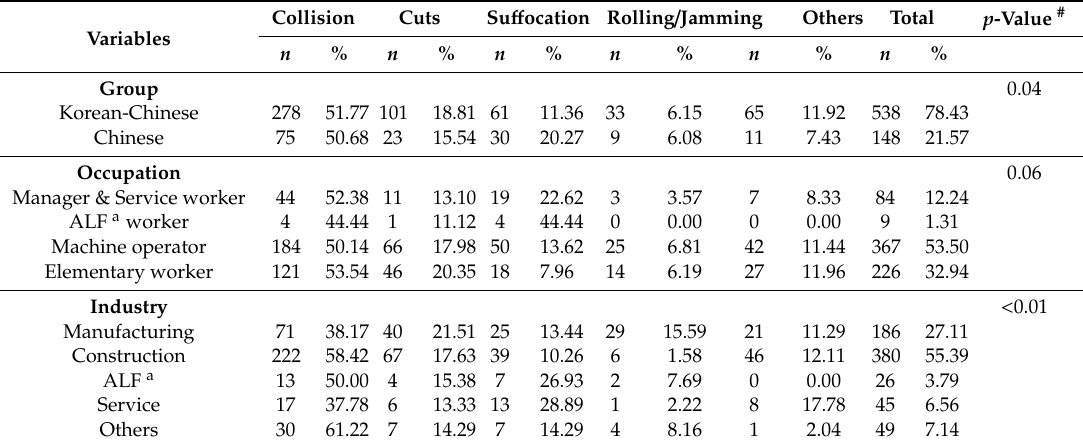
Table 2. Mechanisms of deaths due to occupational injuries according to subjects’ characteristics ( n = 686).